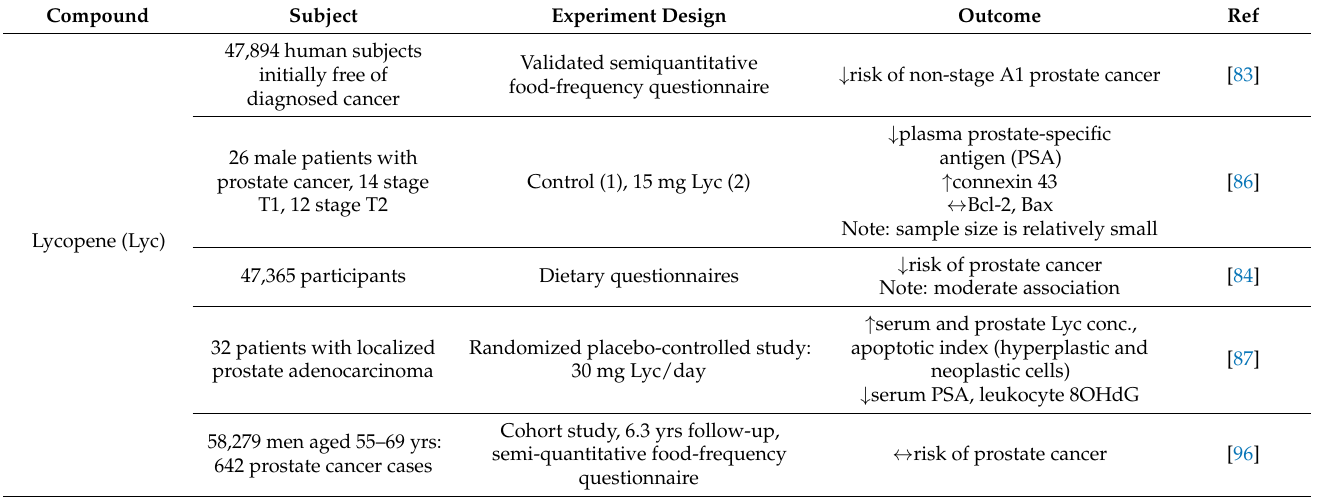
Table 3. Summary of clinical trials evaluating anti-cancer properties of